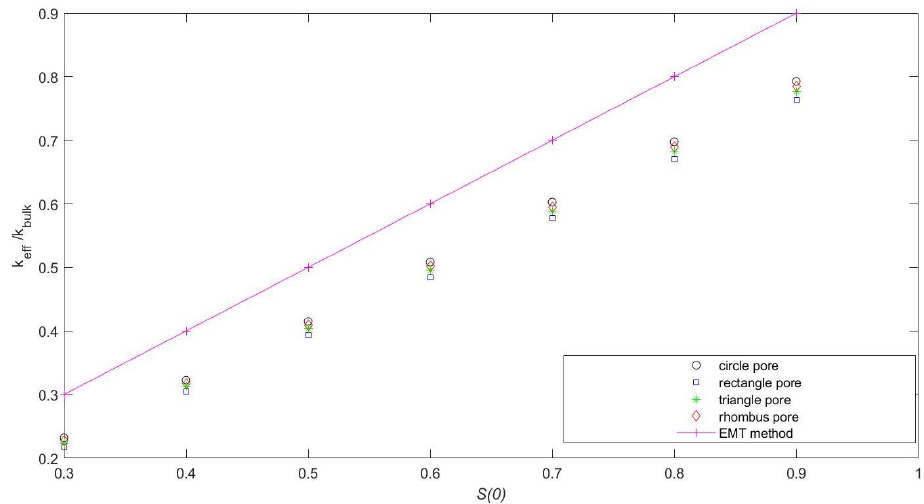
Figure 5. The effective thermal conductivity with the EMT method and the MCBU method with the changes of S (0).